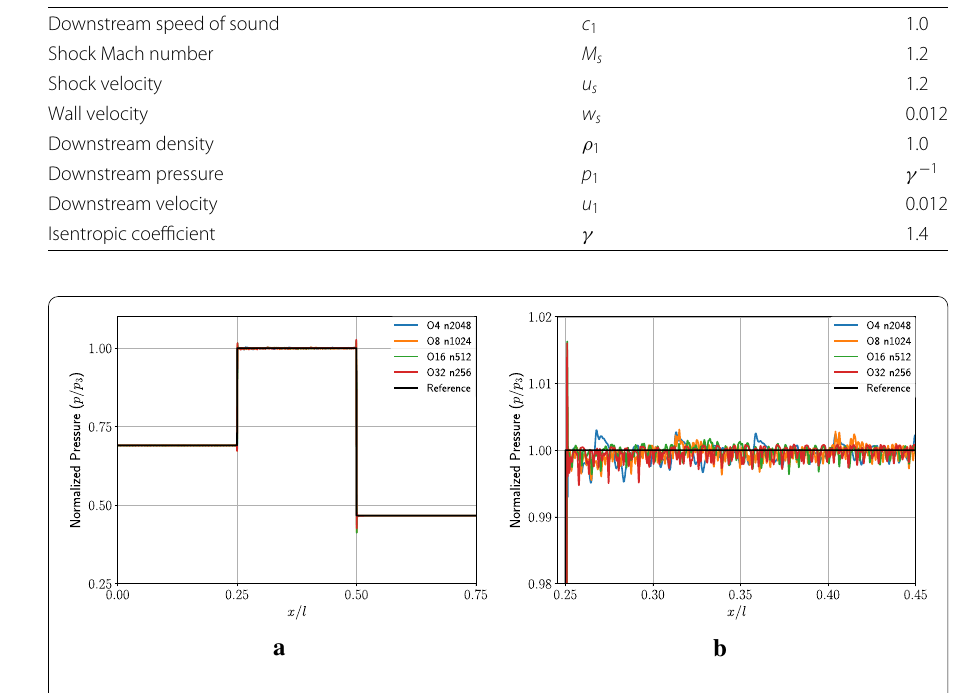
With a shock wave Mach number of M s = 1 . 2 and a wall speed of w s = 0 . 012 the exact solution for the pressure relation across the reflected shock wave is according to Eq. (11) 1 . 44911145. The simulation domain for this test case is the unit interval of x ∈ [0 , 1] with the wall initially located at x = 0 . 49437415. Hence the porous material covers at t =